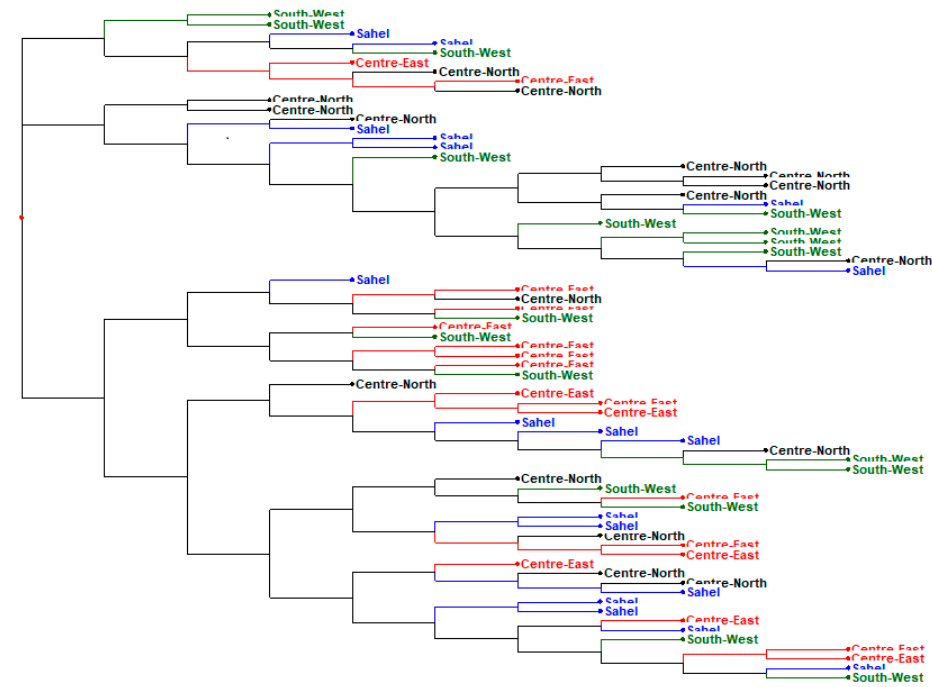
Figure 3. Dendrogram obtained by neighbour-joining cluster analysis among four local chicken ecotype in four regions evaluated using 20 microsatellites markers.